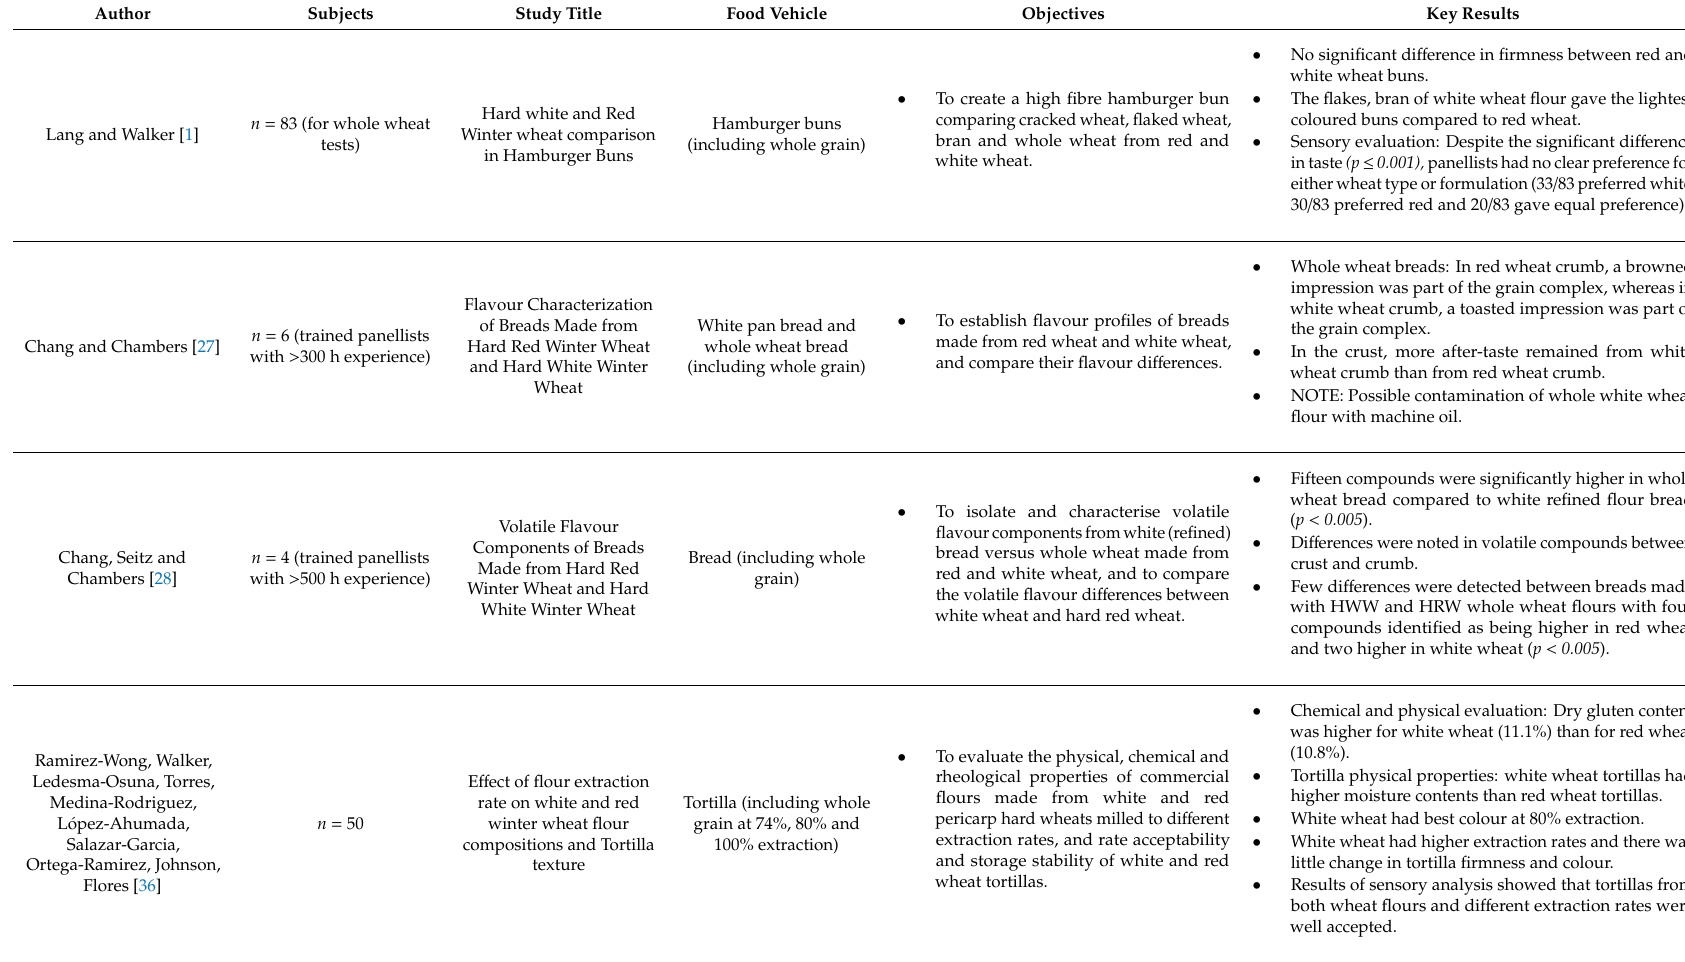
Table 2. Red and white wheat sensory with physico-chemical analysis published